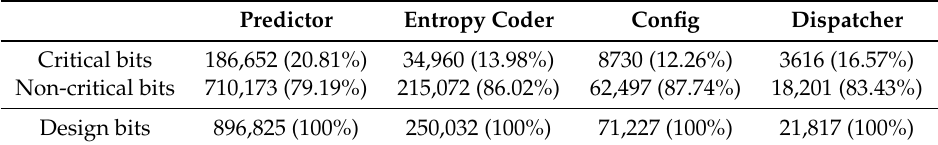
Table 2. Intrinsic reliability of the different modules of the CCSDS 123.0-B-1 IP core (AVIRIS